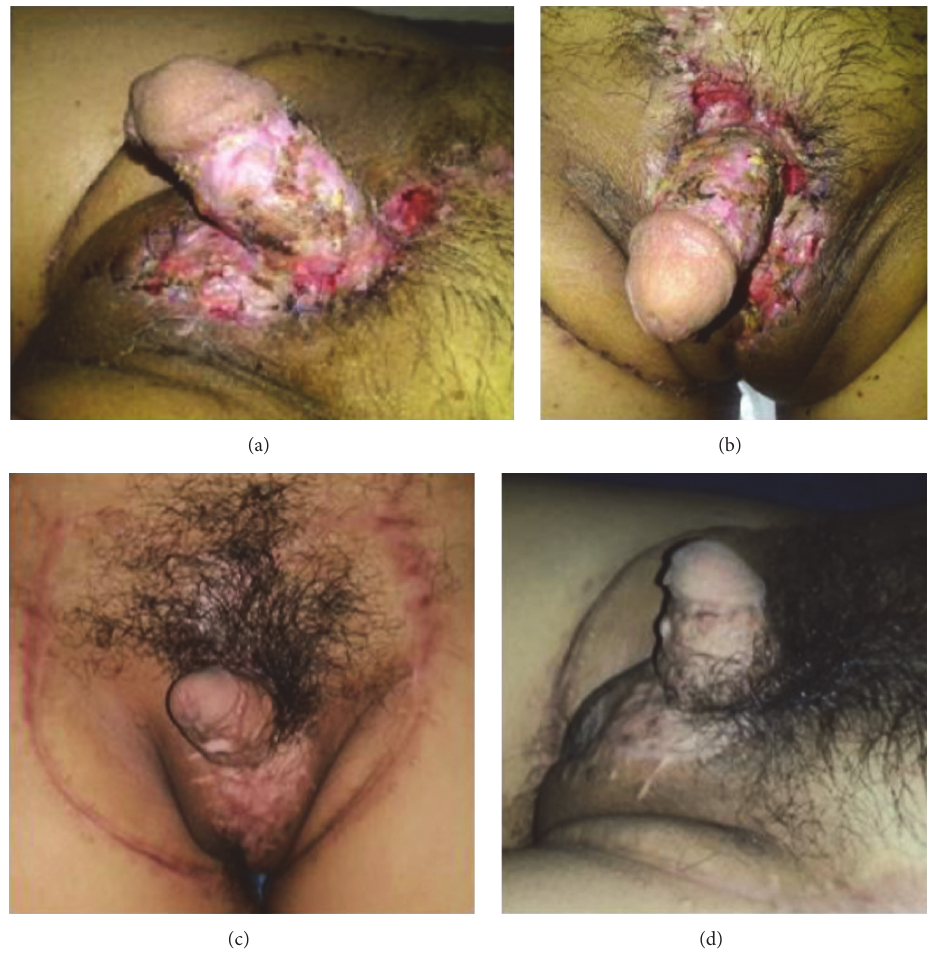
Figure 5: One-month follow-up (a, b) and 4 months (c, d) after surgery.